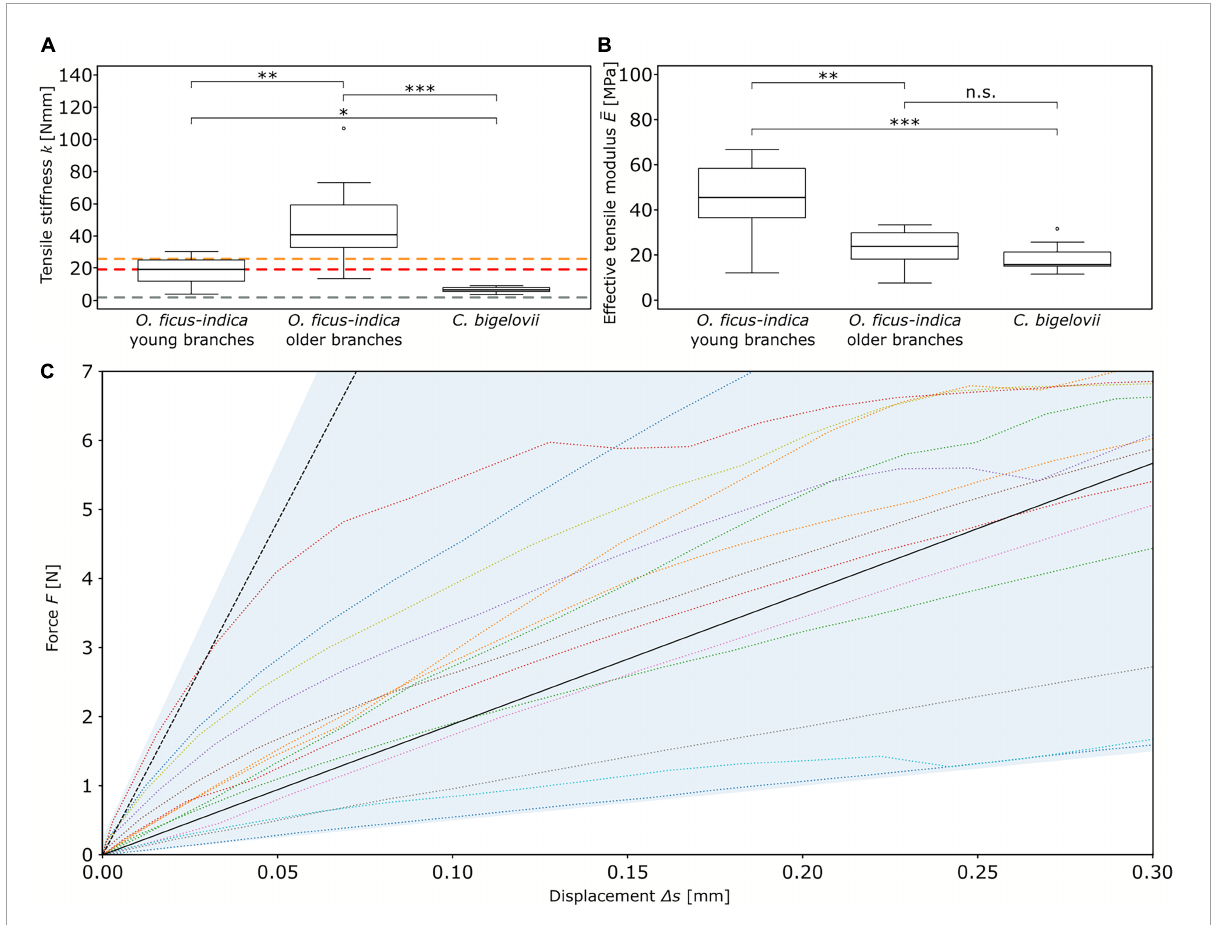
FIGURE3 Elastic behavior of the branch-branch junctions under tensile loading. Box plots of the (A) tensile stiffness k and (B) effective tensile modulus E of the three analyzed groups. The colored dashed lines in (A) mark the tensile stiffness values obtained from “Opuntia_model_young” (red line), “Opuntia_model_older” (orange line), and “Cylindropuntia_model” (gray line). The sample size was 14 for the two groups of O. ficus-indica and 15 for C. bigelovii . Levels of significance between the groups are marked as follows: p ≥ 0.05: not significant (n.s.); 0.05 > p ≥ 0.01: significant ( ∗ ); 0.01 > p ≥ 0.001: very significant ( ∗∗ ); 0.001 > p : highly significant ( ∗∗∗ ). (C) Force-displacement curves of the junctions of O. ficus-indica with young lateral branches tested under tensile loading (colored dotted lines, with the range of the data shaded in light blue) and the simulation of the FE models (black lines). The dotted black line refers to the “standardized geometric model” in which the thickness of the shell of vascular bundles corresponds to the biological value, whereas the solid black line refers to the “adjusted geometric model” with a reduction in thickness of the shell of vascular bundles making up for their net-like